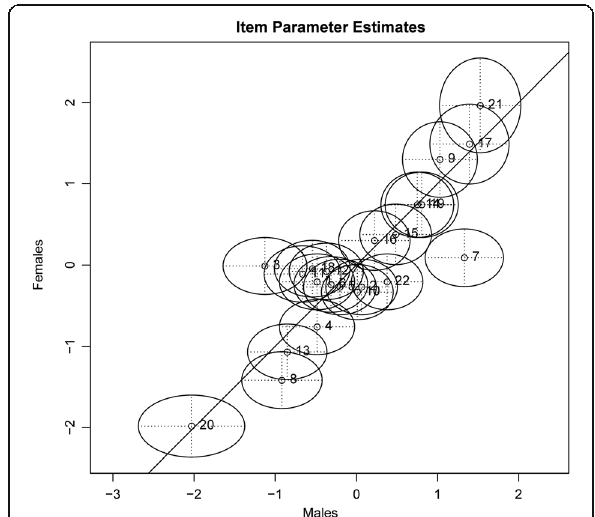
Fig. 3 Exemplary graphical model test with 95% confidence regions and gender as splitting criterion. Item numbering does not correspond to the final item numbering. The estimated item parameters for males are plotted on the x -axis, and the estimated item parameters for females are plotted on the y -axis. Item parameter estimates are surrounded by 95% confidence regions. Significant deviation from the diagonal indicates an item ’ s subgroup heterogeneity. For items 3 and 7, parameter estimations differed markedly between males and females. Item 3, which addressed the deceleration of a car that is moving with constant speed, was easier to solve for males. Item 7, however, which addressed the interaction between the Earth and the Moon, was easier to solve for